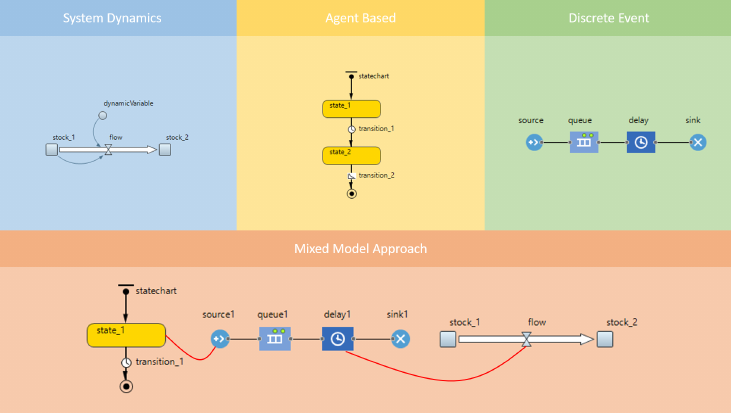
Figure 10. Combining System Dynamics, Agent Base,d and Discrete Event into a Mixed Model Approach.